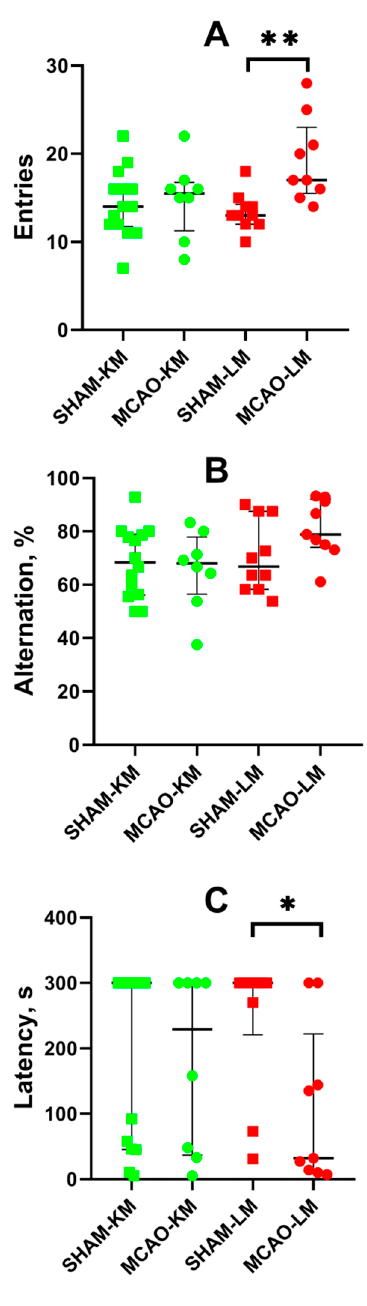
Figure 7. Effects of focal brain ischemia on behavior of MCAO-KM and MCAO-LM groups in the Y-maze ( A , B ) and passive avoidance test ( C ) 3 months after surgery. ( A ) Number of entries into the arms of Y-maze. ( B ) Alternation (%). ( C ) Step-through latency in the passive avoidance test, s. * p < 0.05 and ** p < 0.01 (Mann–Whitney U